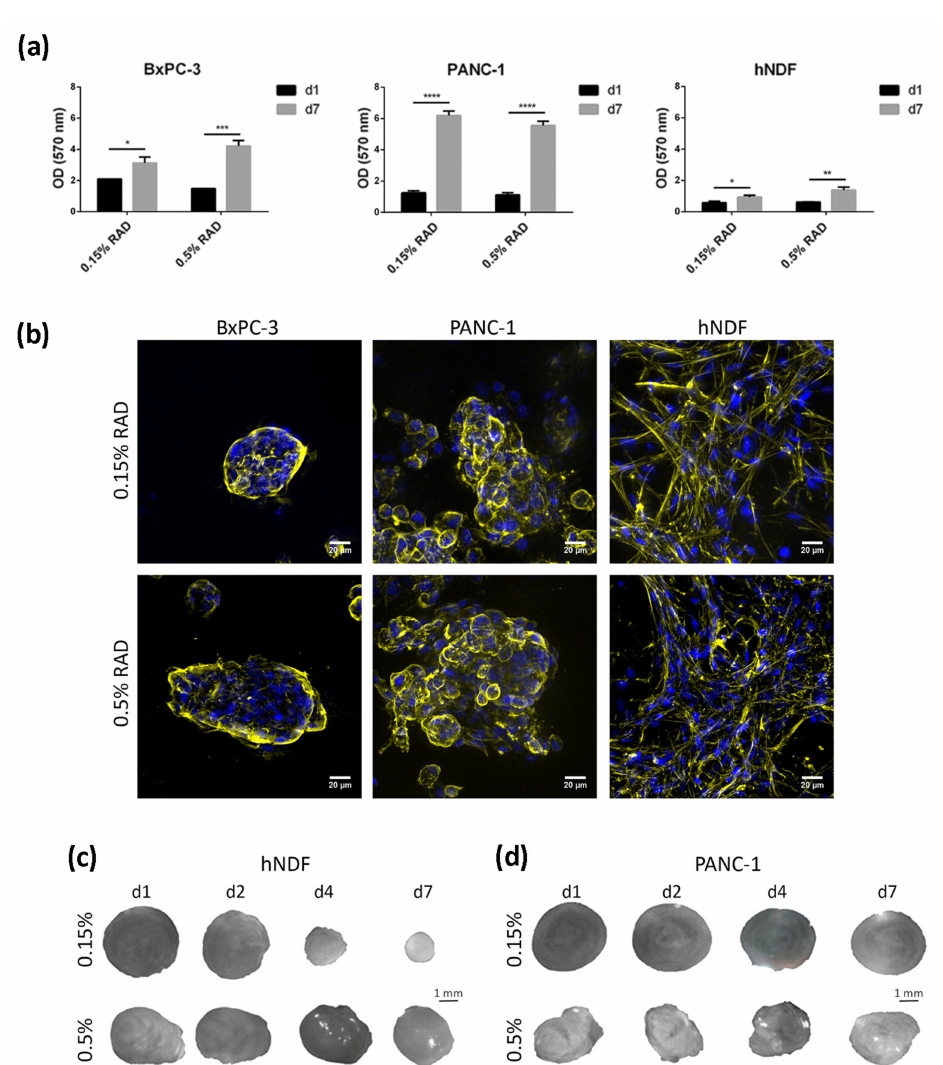
Figure 1. Cell culture in RAD16-I scaffold. ( a ) Viability of BxPC-3, PANC-1 and hNDF cultured in 0.15% and 0.5% RAD16-I scaffold measured by MTT assay at day 1 and day 7 of culture. Statistical differences are indicated as * for p < 0.05, ** for p < 0.01, *** for p < 0.001 and **** for p < 0.0001, two-way ANOVA, N = 2, n = 3); ( b ) Z-projection pictures of BxPC-3, PANC-1 and hNDF cells at day 6 of culture stained with Phalloidin (pseudo-colored in yellow) and DAPI (blue). Scale bars represent 20 µ m; ( c ) macroscopic view of hNDF and ( d ) PANC-1 3D constructs in 0.15% and 0.5% RAD16-I scaffolds at different time